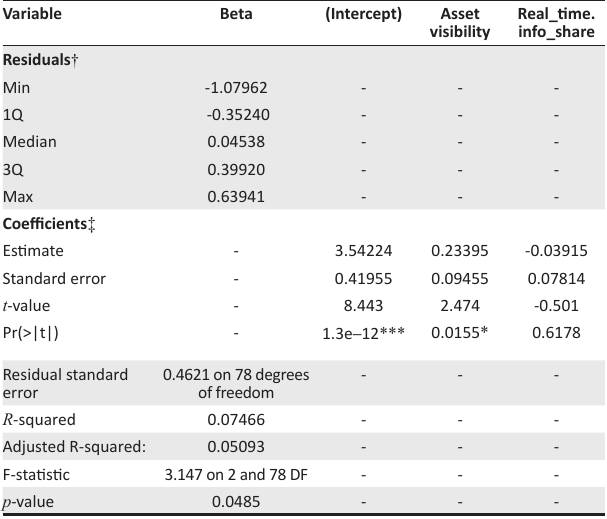
TABLE 6: Regression model results: R regression model and